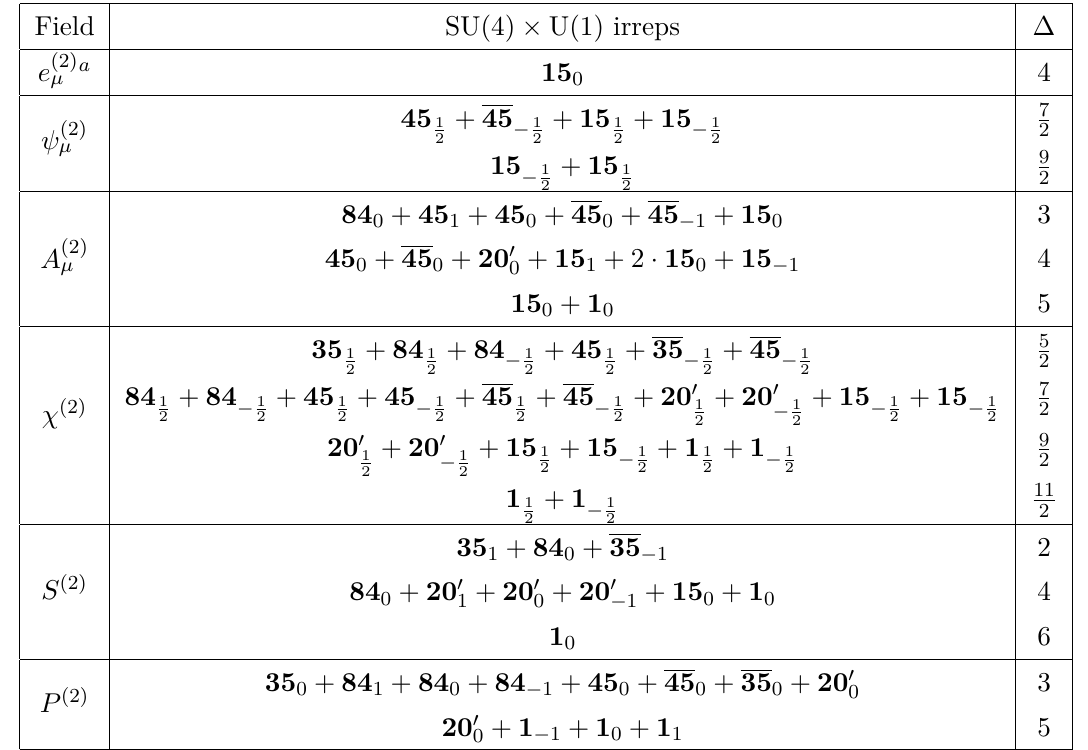
Table 10 . The KK spectrum for level n = 2 of 11d supergravity on AdS 4 × S 7 / Z 4 with the antiperiodic spin